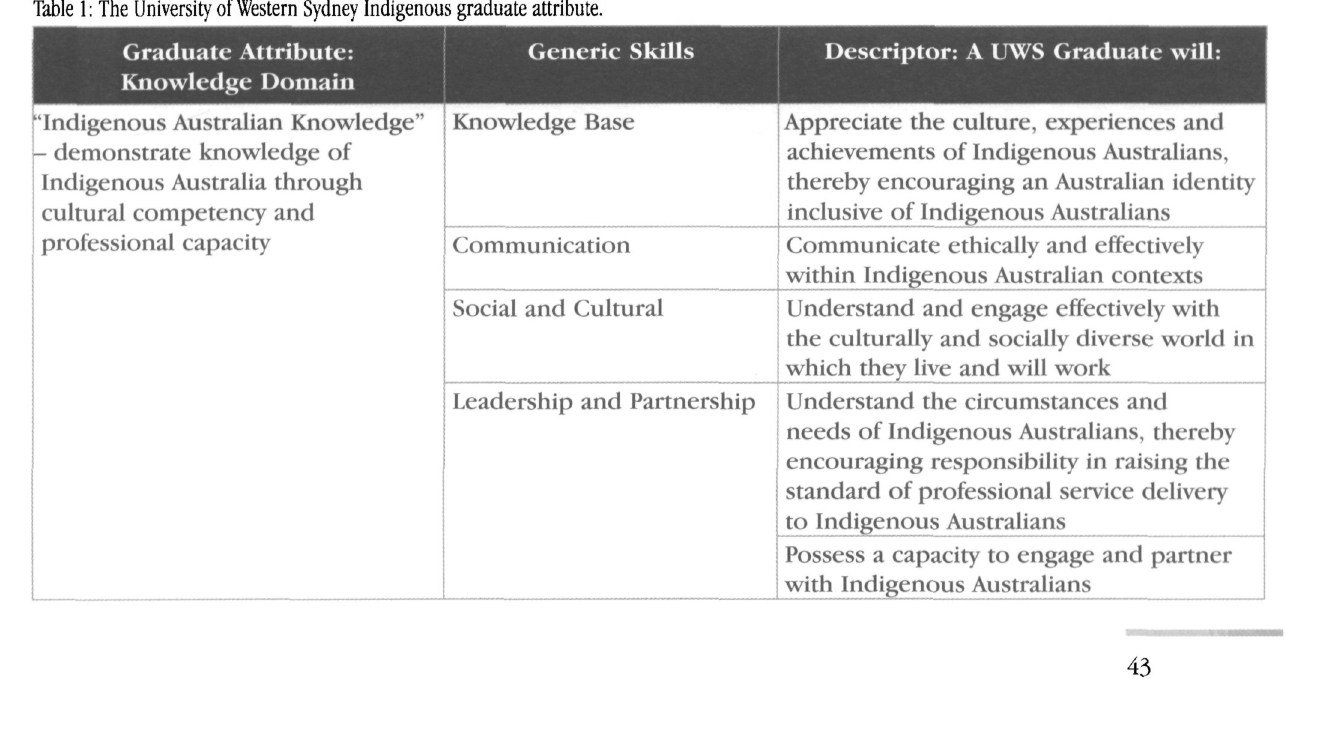
Table 1: The University of Western Sydney Indigenous graduate